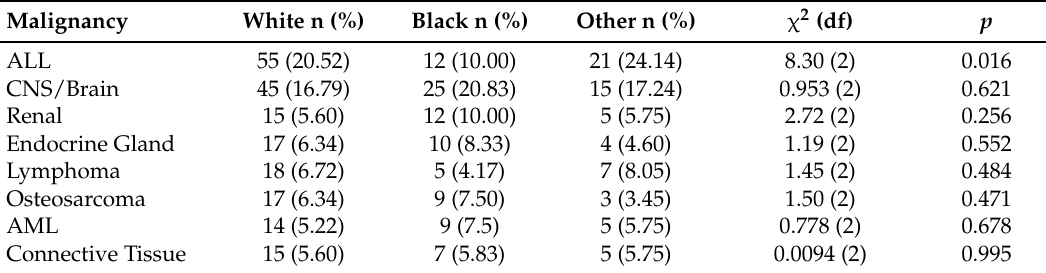
Table 6. Major childhood cancer distribution by race in Delaware 2004–2014.